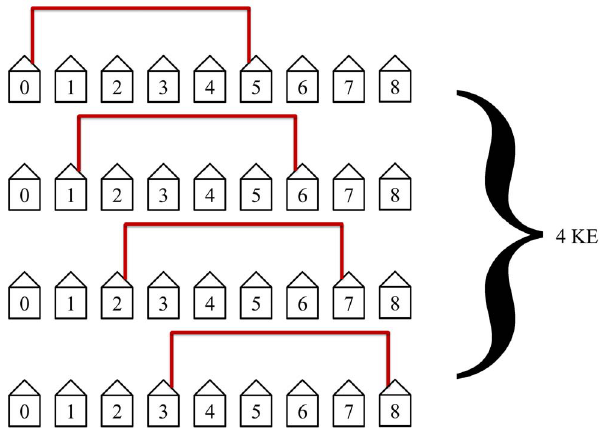
Figure 19. The sixth step in the protocol connects the sixth nearest neighbors. This step requires only 3 KEs since it is the third to last step and there are only three possibilities.